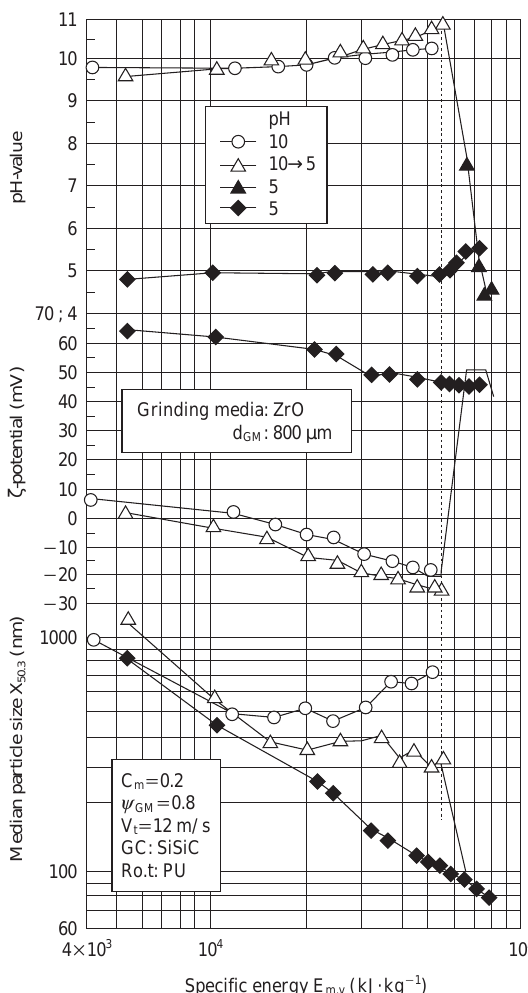
Change of product particle size, zeta-potential and pH- value with the specific grinding